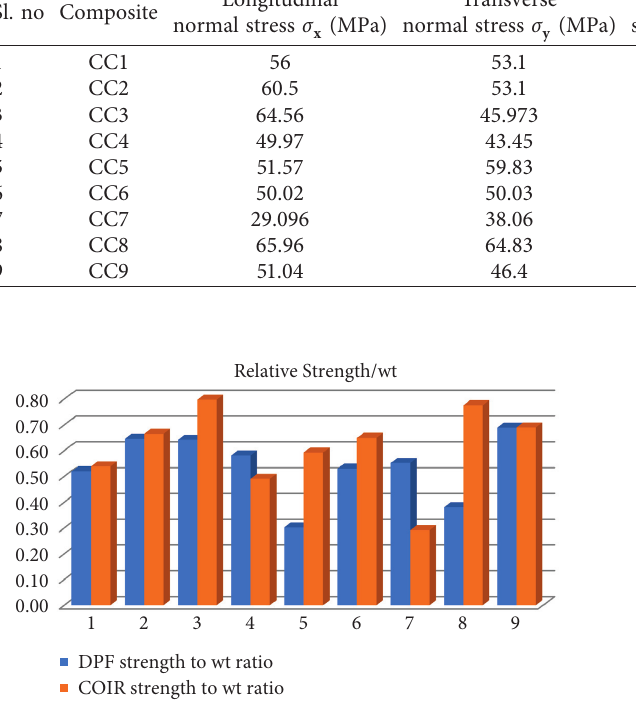
Figure 13: Relative compressive strength/weight ratios of composites.